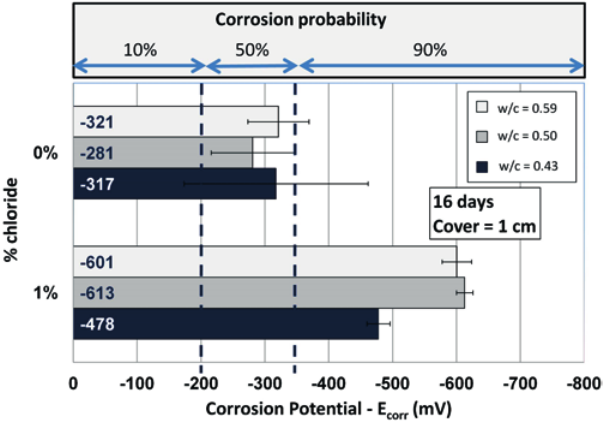
Figure 11 Influence of contamination by chlorides on corrosion potential with w / c = 0.43; 0.50 and 0.59 – concrete cover = 3